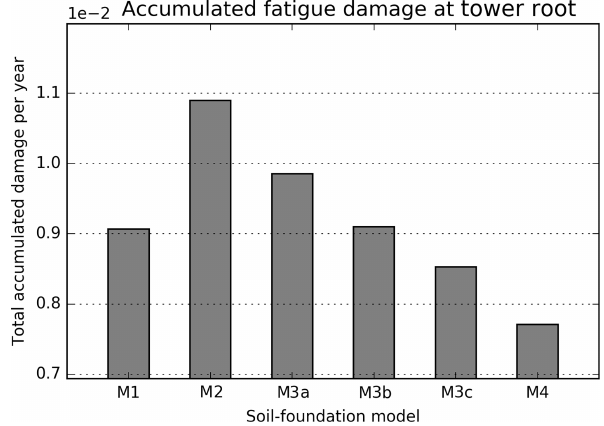
Figure 23. Accumulated fatigue damage at tower root.